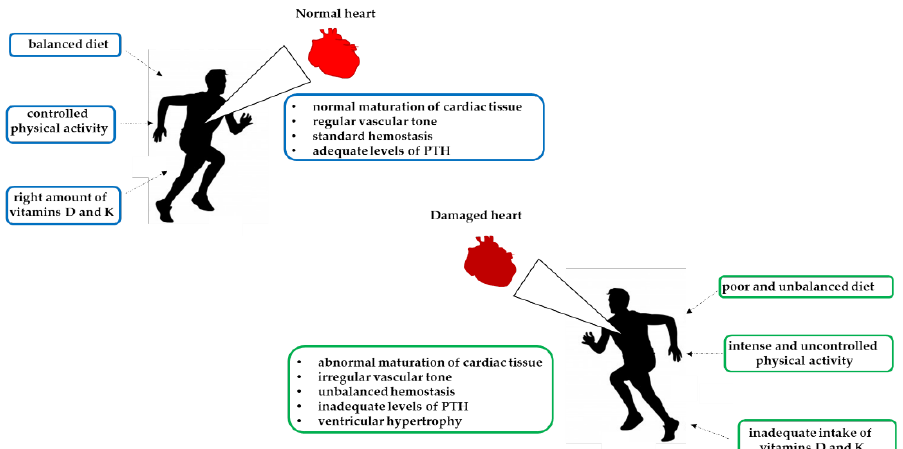
Figure 3. Schematic representation of hypovitaminosis effects and strenuous exercise on the heart.